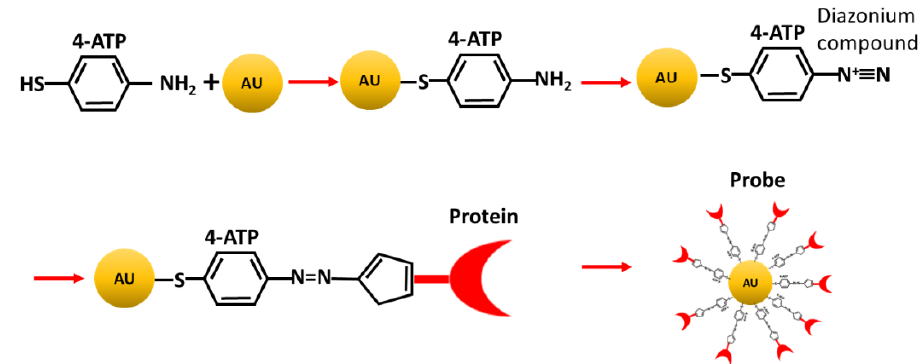
Figure 2. Sketch of the main steps for probe preparation. 4-ATP reacts with gold NP to form the 4-ATP-NP system which is successively activated to yield the diazonium compound able to reacts with a protein target, giving rise to the final probe (4-ATP-NP-pro) (see also the text). The Raman spectrum of 4-ATP, as obtained by an excitation of 633 nm, is shown in Figure 3a. In the − 1 1000–1500 cm region, the spectrum exhibits three main bands, with other small peaks being hardly − 1 detectable. At 2555 cm , a band, attributed to the stretching vibration of –SH group of 4-ATP, is also present (see the inset in Figure 3a) [68]. The assignment of the main bands to the 4-ATP vibrational modes is reported in refs. [39,68]. The Raman spectrum of 4-ATP as obtained by using an excitation wavelength of 514 nm is almost the same (not shown) [40].